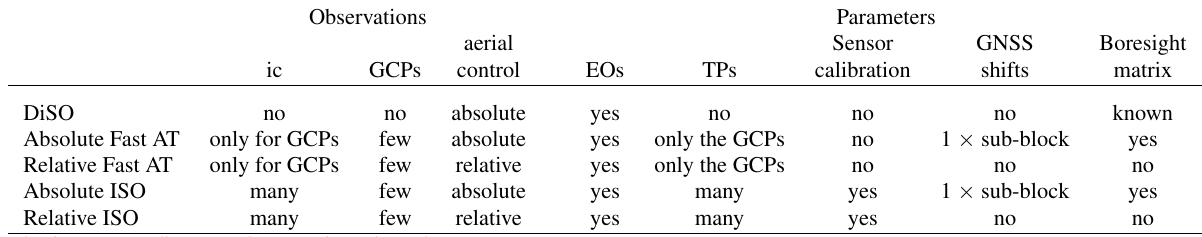
Table 1: Observables and estimable parameters for DiSO, Fast AT and ISO procedures.